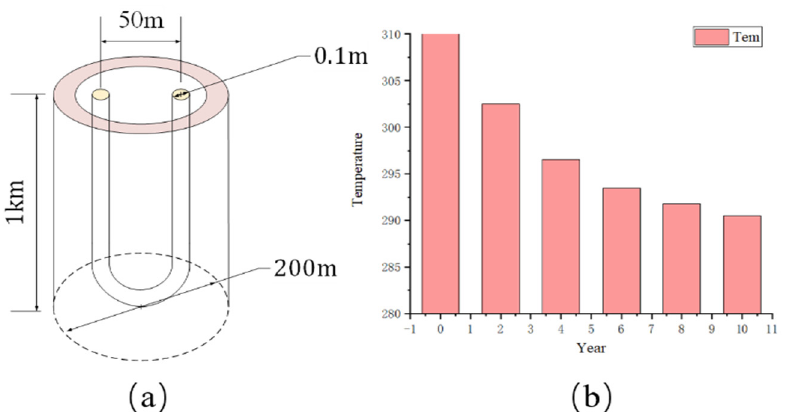
Figure 4. Temperature distribution and streamlines for GPG after 10 years (two color scales: left , temperature; right , pressure).